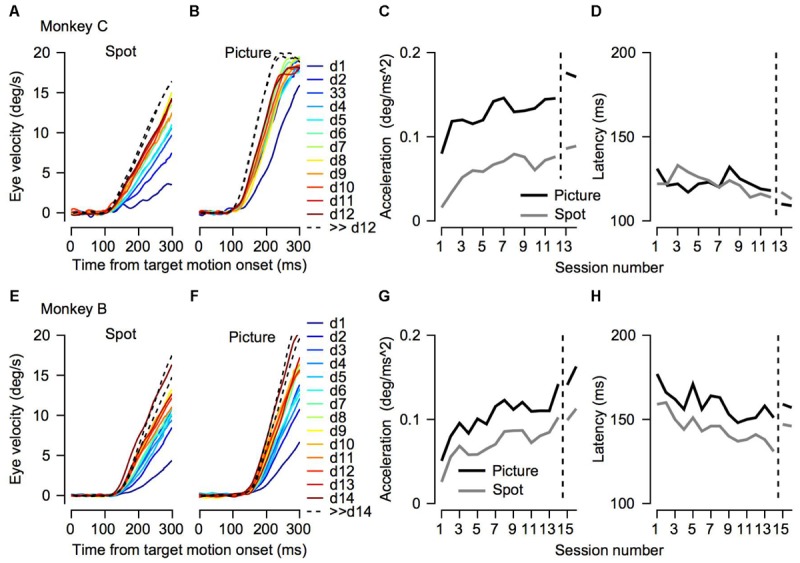
Initial eye velocity traces across training sessions. (A,B,E,F) Eye velocity as a function of time from target motion onset. Each thin line shows the average eye velocity in a single session. Colors correspond to the color code on the right and represent the session number. The progression from dark blue through green to dark red corresponds to the session number starting from the 1st day of training. The black dashed traces show the data from sessions that were recorded after many days of training on pursuit tasks. Different columns correspond to the different target conditions. (C,D,G,H) Decomposition of the eye velocity traces to the slope of linear regression (linear acceleration; C,G) and latency (D,H). The horizontal axis represents the session number. Values to the right of the vertical dotted line were recorded after extensive training on pursuit tasks. Presented values were extracted from the average traces. The top (A–D) and bottom (E–H) plots shows data for Monkeys C and B.